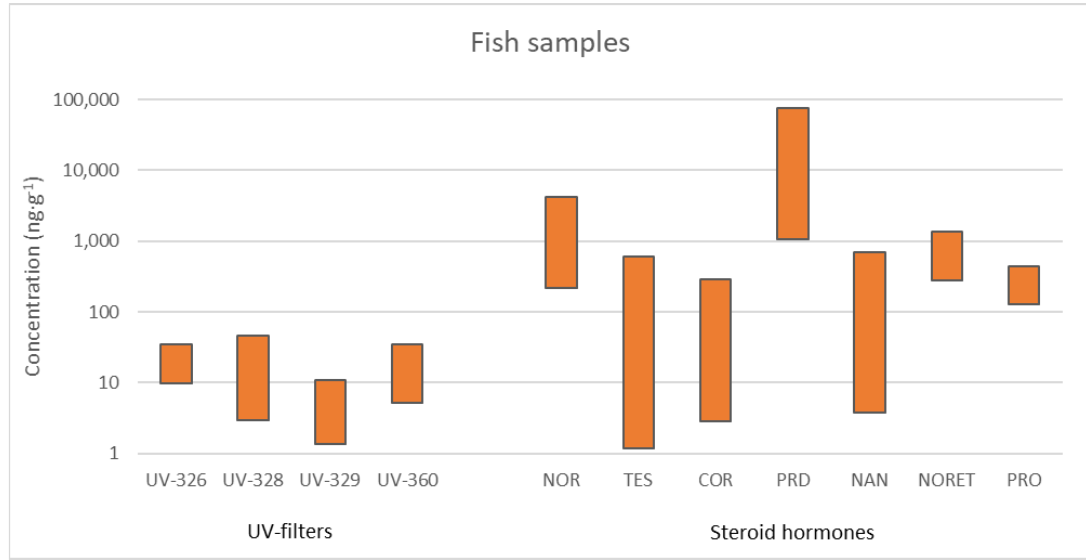
Figure 5. Range of concentrations (ng g −1 ) for detected BUVSs and steroid hormones in fish samples. In a first evaluation of the presence of steroid hormones in fish tissue, samples of Boops boops and Sphoeroides marmoratus captured close to the marine outfall of the largest WWTP were analysed to determine whether these species present measurable concentrations of steroid hormones. In this sense, steroid hormones were evaluated in the muscle, viscera, and skin of both species. The behaviour in both species was similar, and muscle samples exhibited the highest number of detected steroid hormones (up to 7 of 15 compounds under study). Nevertheless, their concentrations were in most cases below the quantification limits. In contrast, viscera samples exhibited fewer positive compounds (4 of the 15 studied compounds), but the concentrations were significantly greater than those in muscle samples. Regarding skin samples, they exhibited the lowest positive analysis, and the concentrations were much lower than those observed in viscera. No significant differences were observed between the two fish species despite the differences between them. The concentrations of the eight detected compounds ranged from less than the quantification limits to 3.95 µg g −1 [49]. After